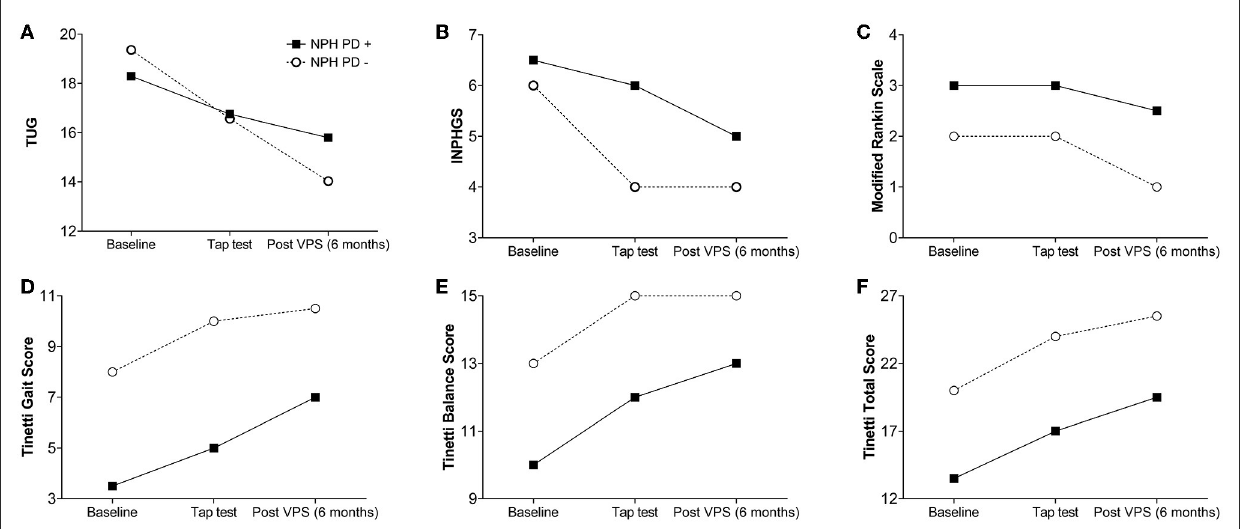
FIGURE1 Spaghetti plot comparing the changes overtime for INPH patients with (INPH-P + ) and without parkinsonism (INPH-P − ) at baseline, 72h after CSF TT, and 6 months after shunt surgery. (A) TUG, (B) INPHGS, (C) modified Rankin scale, (D) Tinetti Gait Score, (E) Tinetti Balance Score, and (F) Tinetti Total Score.